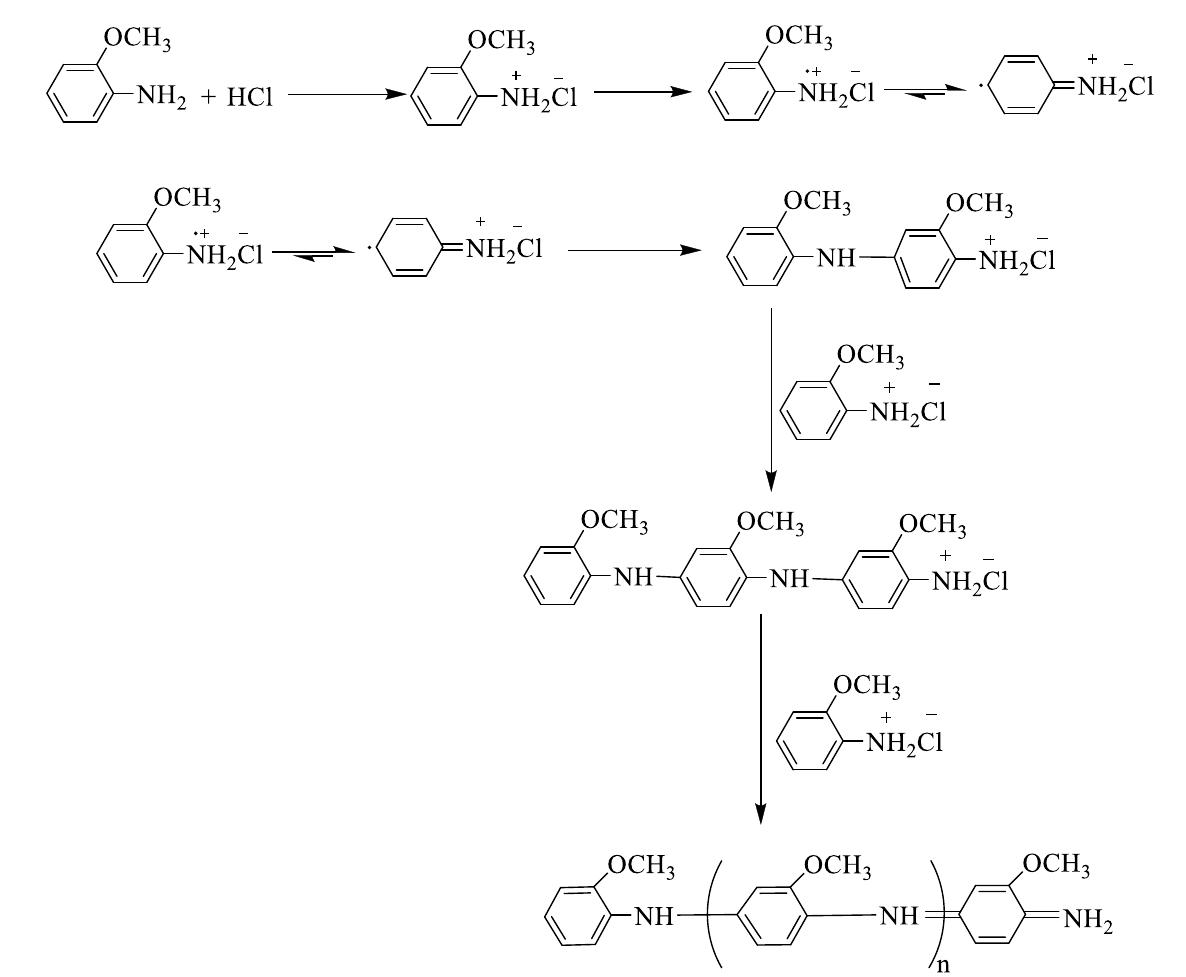
Figure 1. Mechanism of polymerization of o -anisidine.